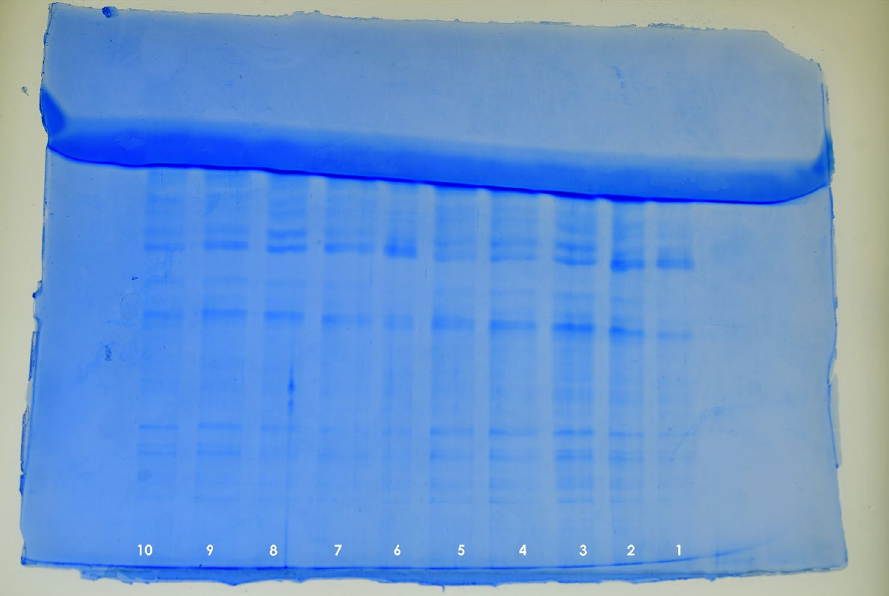
Figure 6. SDS-PAGE of proteins released from Escherichia coli into supernatant on treatment with limonene at 1XMIC and 2XMIC concentration. Lane 1 to 5 1XMIC (Lane 1: 0 min|Lane 2: 30 min|Lane 3: 60 min|Lane 4: 90 min|Lane 5: 120 min). Lane 6 to 10 2XMIC (Lane 6: 0 min|Lane 7: 30 min|Lane 8: 60 min|Lane 9: 90 min|Lane 10: 120